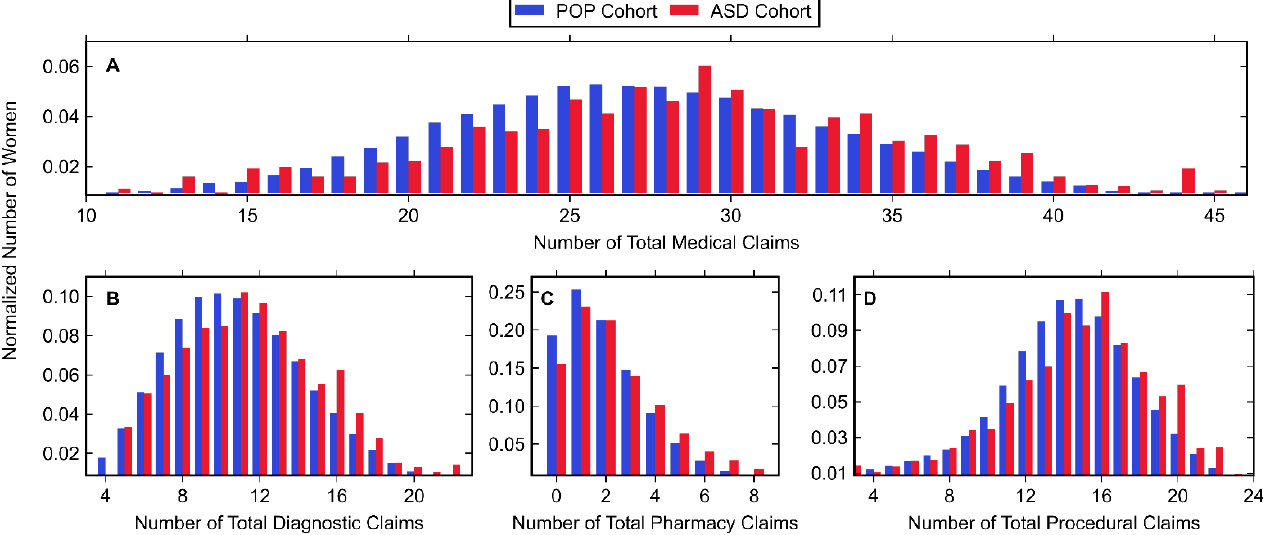
Figure 2. Histogram data of normalized number of women belonging to the POP and ASD cohorts (shown in blue and red, respectively) with ( A ) any medical claim, ( B ) diagnostic claim, ( C ) pharmacy claim, or ( D ) procedural claim. Values associated with small cell sizes are not shown in order to be compliant with OptumLabs’ de-identification policy. Table 5. Statistics on Number of Medical Claims during Entire